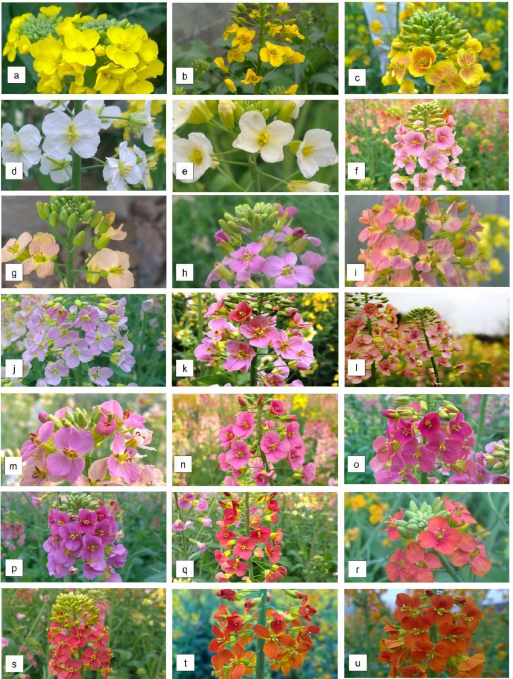
Figure 5. Colorful, non-genetically-modified B. napus accessions with normal seed setting and stable heritability of flower color. ( a ) Control (natural color), ( b – u ): diverse colorful accessions bred